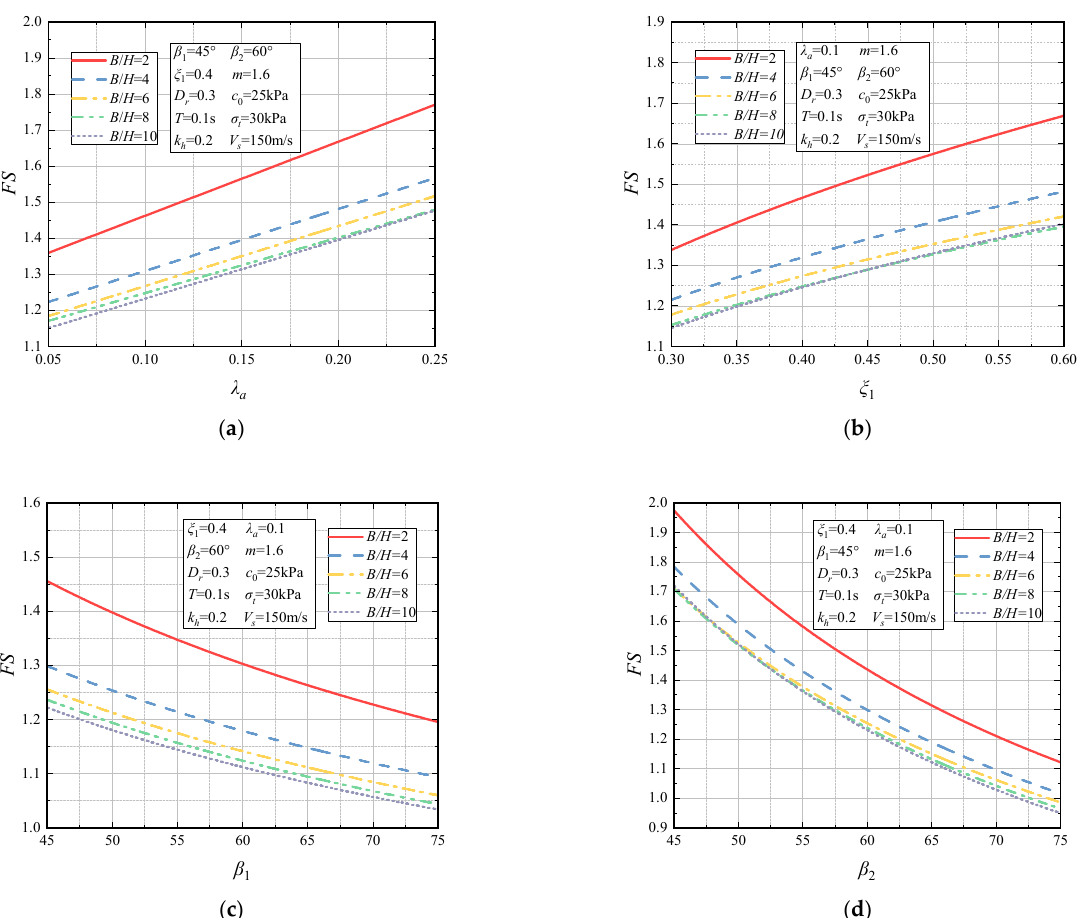
Figure 7. Impacts of geometric factors on the stability for 3D two-step slopes: ( a ) step-width coeffi-